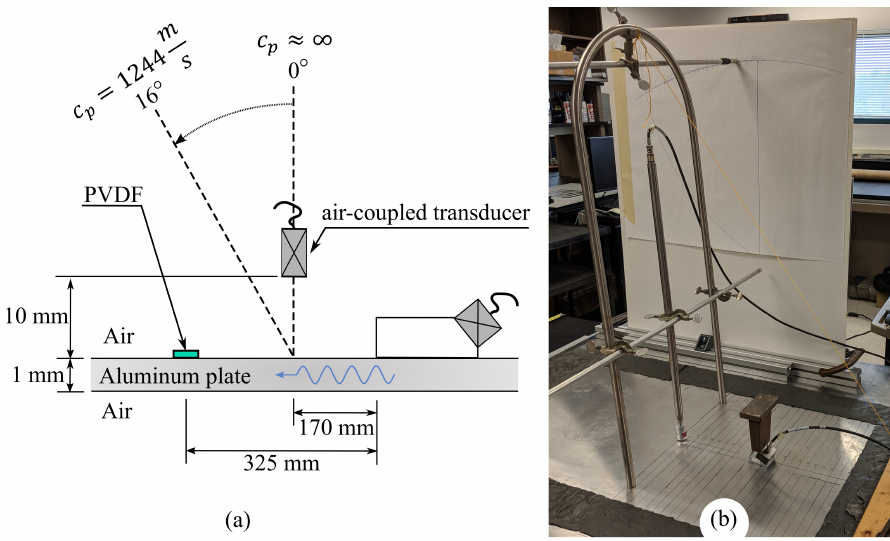
Figure 4. ( a ) Not-to-scale schematic of the experimental setup; and ( b ) picture of the angular positioning frame for air-coupled transducer measurements. The angle wedge transducer for excitation is also shown with dead weight to prevent movement.